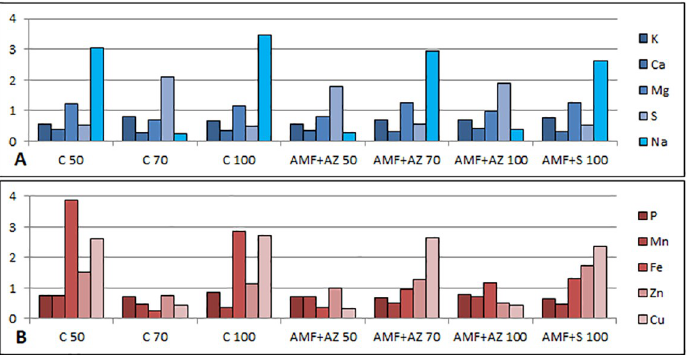
Fig 7. Effects of soil microorganisms application to substrates of different organic matter content on root: Shoot ratio of mineral elements in tomato transplants. C 50 –peat:sand ratio 50:50 (v:v) without inoculation; C 70 –peat: sand ratio 70:30 (v:v) without inoculation; C 100 –peat:sand ratio 100:0 (v:v) without inoculation; AMF + AZ 50 –peat: sand ratio 50:50 (v:v) inoculated with arbuscular mycorrhizal fungi (AMF) and Azospirillum brasilense (AZ), AMF + AZ 70 –peat:sand ratio 70:30 (v:v) inoculated with AMF and AZ, AMF + AZ 100 –peat:sand ratio 100:0 (v:v) inoculated with AMF and AZ; AMF + S– 100 peat:sand ratio 100:0 (v:v) inoculated with AMF and Saccharothrix tamanrassetensis